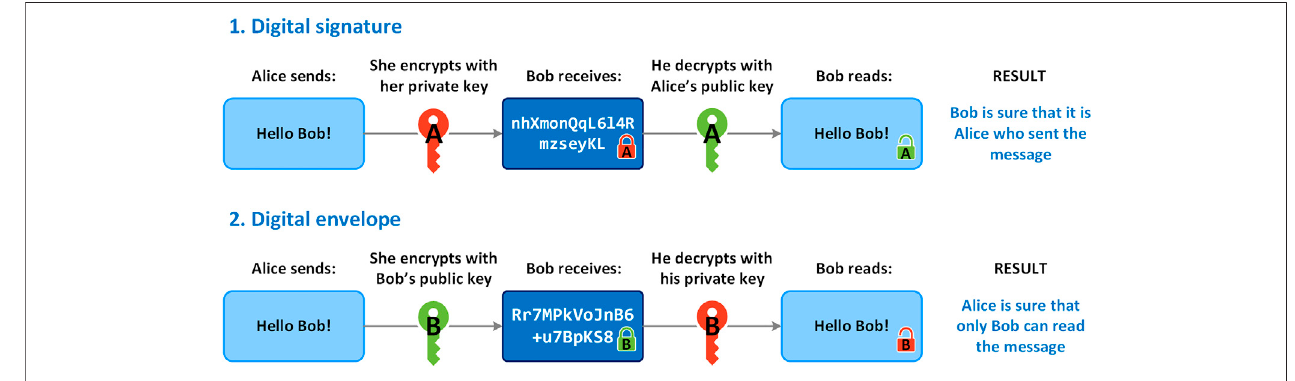
FIGURE 5 | Uses of asymmetric cryptography in message